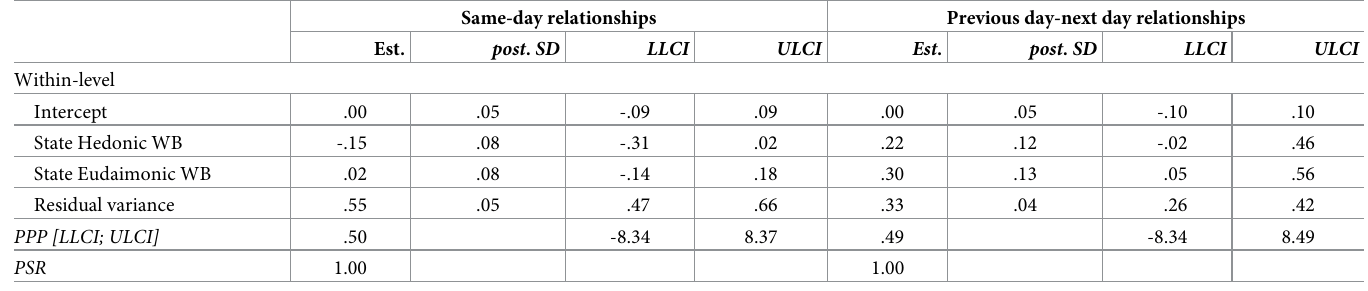
Table 1. Multilevel Structural Equation Models predicting state extra-role performance from state eudaimonic well-being.